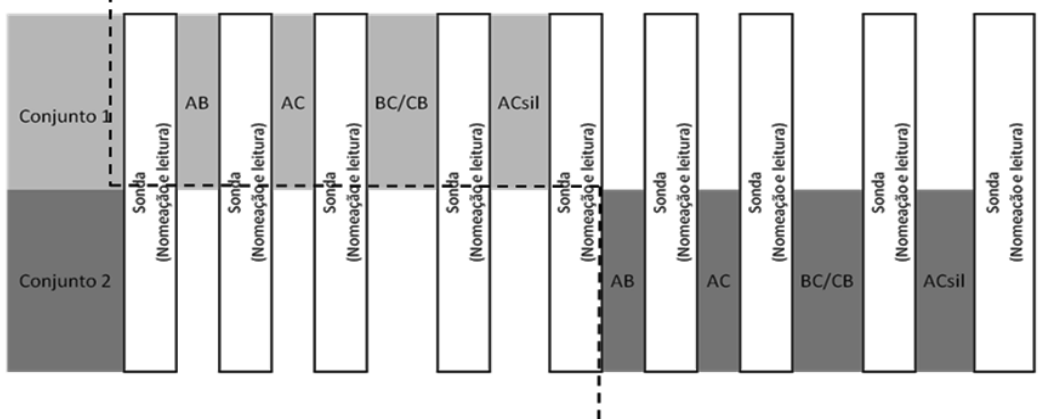
Figura 1 . Diagrama ilustrativo do delineamento de linha de base múltipla com sondas de vocalização (barras brancas) antes e depois do ensino de diferentes relações e do teste de formação de classes com estímulos dos Conjuntos 1